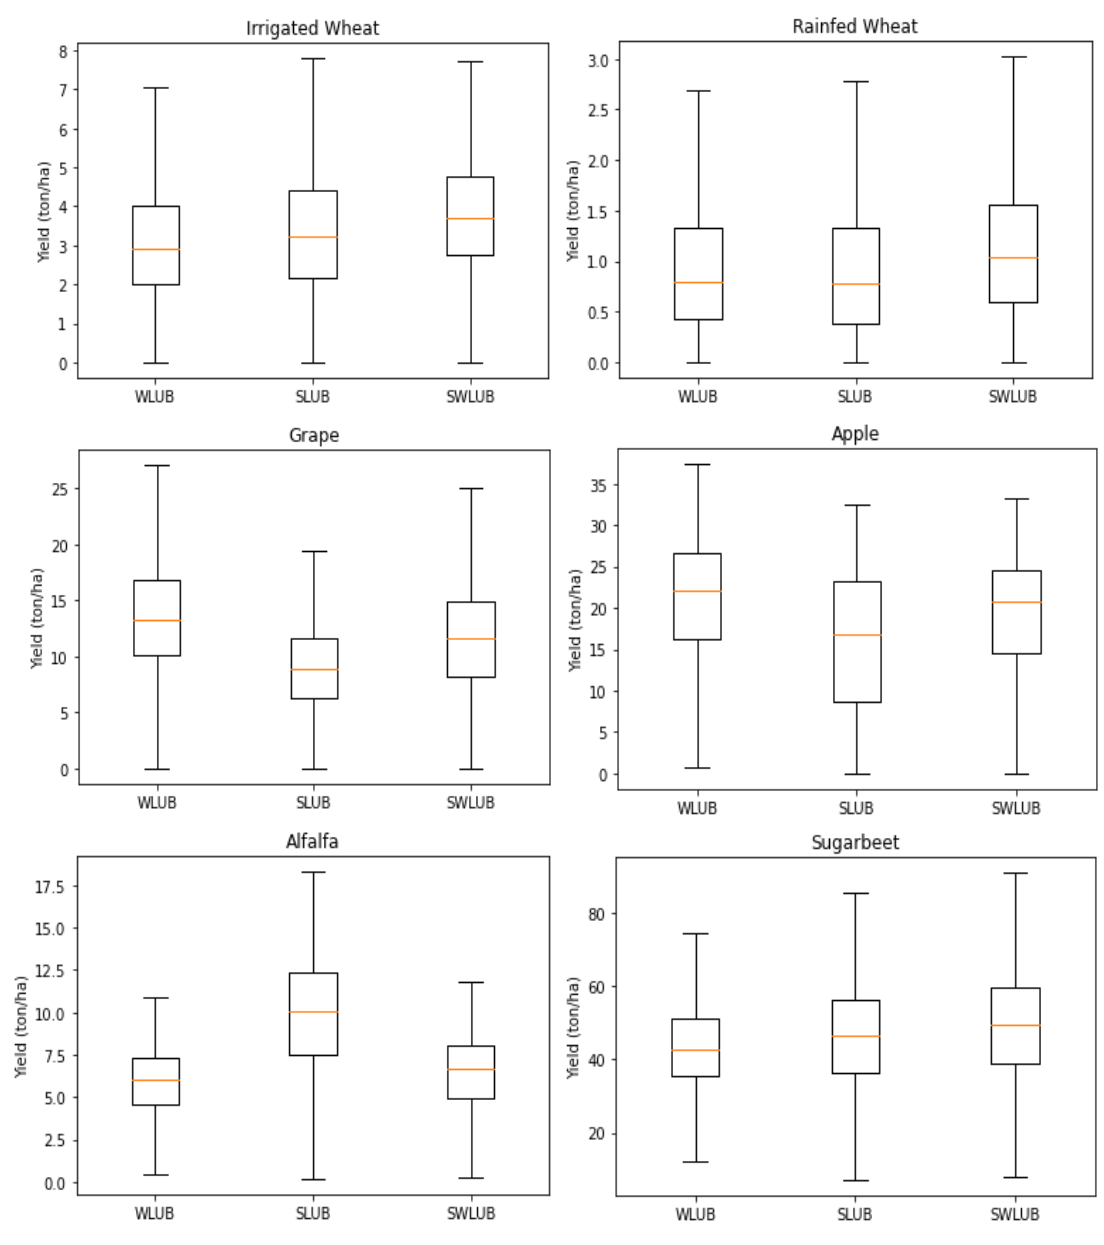
Figure 12. Spatial variation of crop yield at each agricultural site in